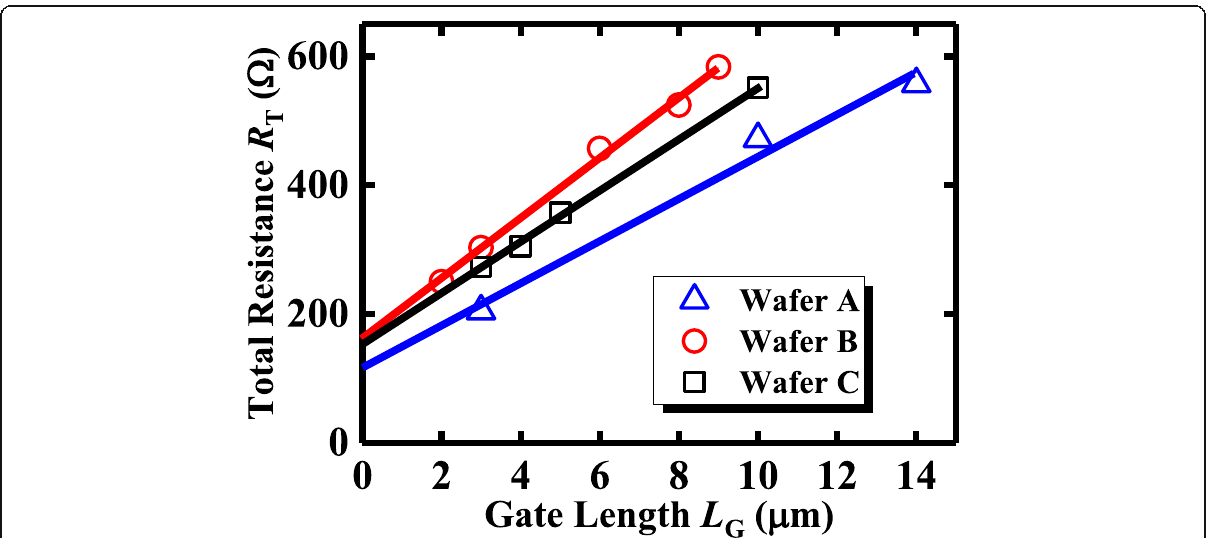
Fig. 7 Total resistance ( R T ) versus gate length ( L G ) of Ge